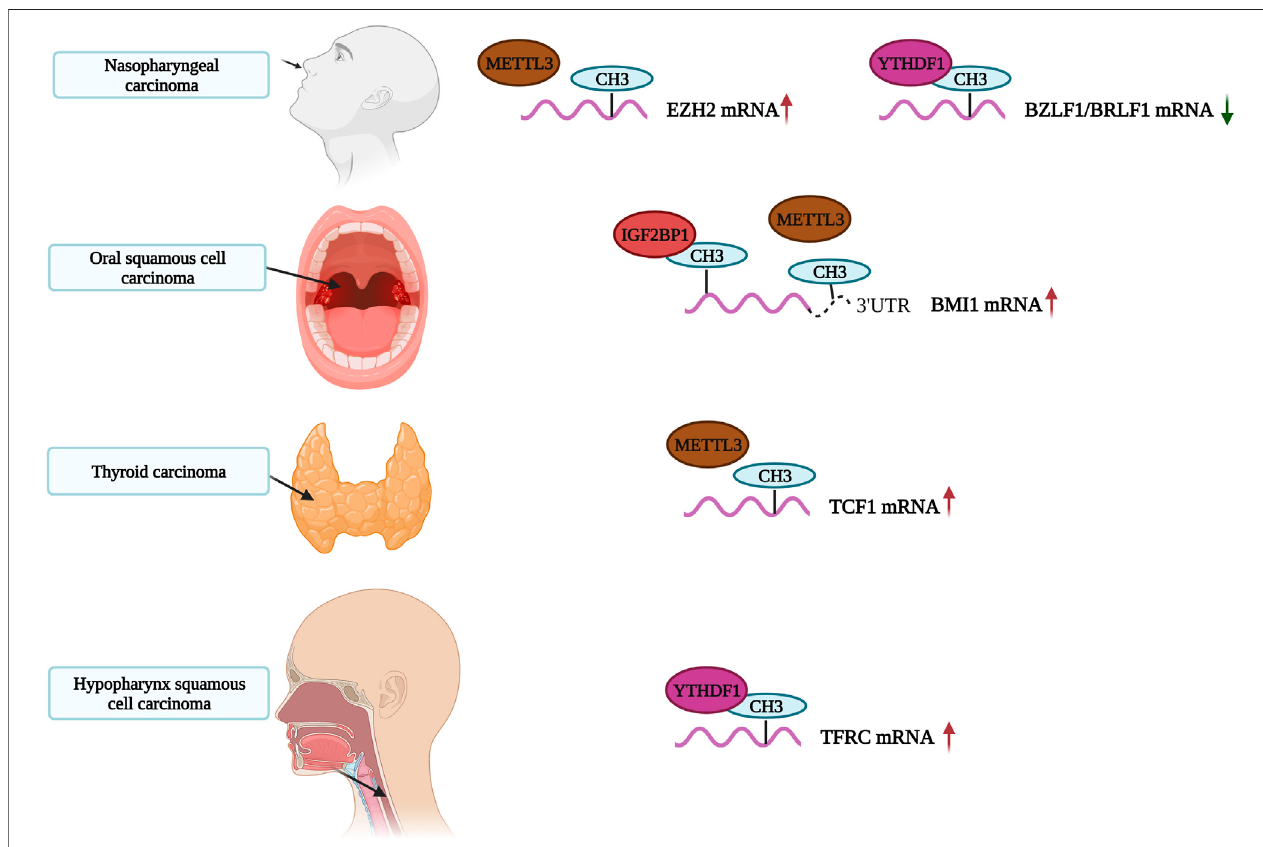
FIGURE 4 | The role of m 6 A in Head and Neck Carcinoma. The m 6 A-modi fi ed RNA play an important role in the occurrence and development of Head and Neck